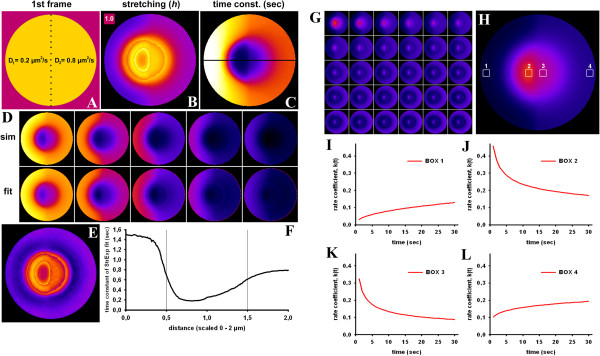
Simulation of heterogenous diffusion and fitting with the StrExp function. A 2-dimensional bleaching experiment was simulated on a disk with a circular bleached area of radius r1=0.5 μm using FeniCS, an automated computational modelling suite (http://www.fenicsproject.org). The bleaching rate is set to k=10 sec-1 and the diffusion coefficient is d1=0.2 μm2/sec and d2=0.8 μm2/sec on the left and right half disk, respectively (A). Fluorescence loss inside and outside the bleached region was fitted at every pixel position with the StrExp function. For this purpose the PixBleach plugin to ImageJ was used [40]. The regression recovers a map of the stretching parameter, h, color-coded between 0.4 to 2.0 (B), the time constant distribution color-coded between 1.0 to 15.0 sec (C) and the χ2-map color-coded between 0 to 50 (E). A FIRE-LUT was used for color-coding, where dark blue and yellow indicate lowest and highest values, respectively. The reconstructed stack exactly resembles the simulated data set, as seen in D (upper row, simulated data (‘sim‘), lower row, regression (‘fit‘)). F, profile of time constants, as estimated from fitting the StrExp function to the simulated FLIP data along the line shown in panel C. G-L, rate coefficients were calculated on a pixel-by-pixel basis according to kt=1h·τ0·tτ01h−1 with self-programmed macros to ImageJ. Rate coefficients are color-coded using a FIRE-LUT in the range from 0.017 (dark blue) to 0.97 (yellow). G, shows montage of all time points; H, first frame of montage with some regions of interest (boxes 1 to 4) used for analysis in panel I-L. Rate coefficient as function of time averaged for box 1 (I), box 2 (J), box 3 (K) and box 4 (L) from the whole sequence.